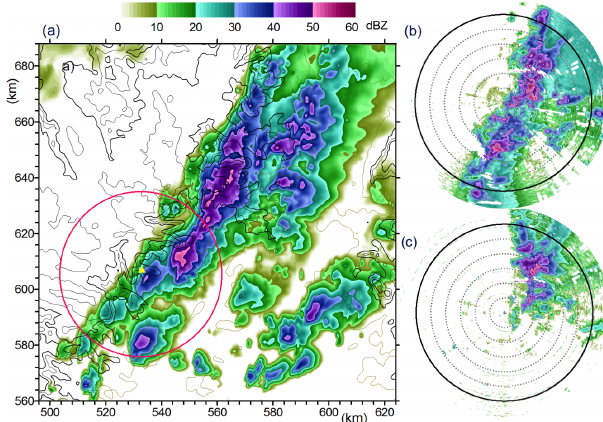
Figure 5. X-band radar reflectivity simulated for the HymRef scenario at 07:50UTC (a) and observed by the X3 radar at 07:50UTC (b) and at 09:06UTC (c) . The red circle in (a) displays the 30km radius range of the X-band